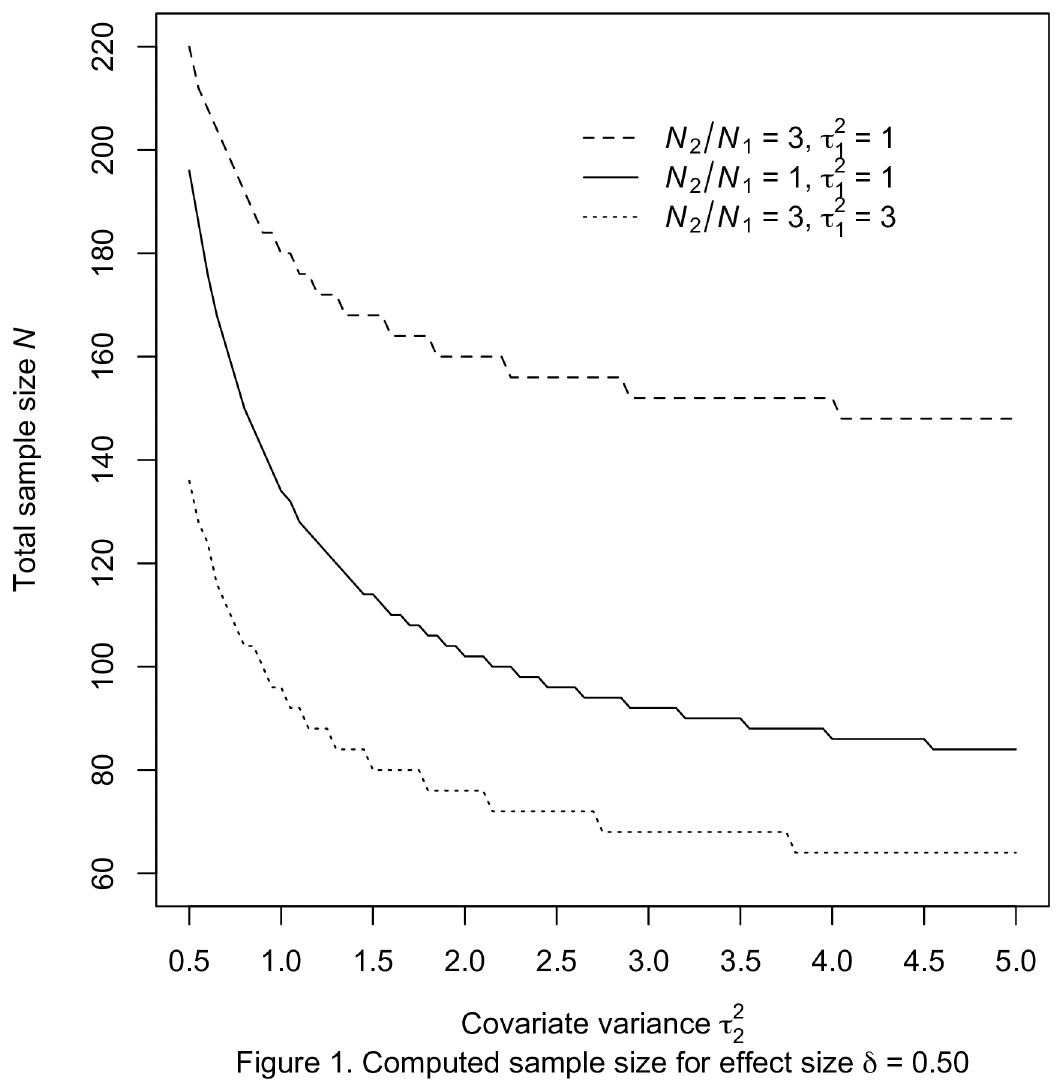
Fig 1. Computed sample size for effect size δ =